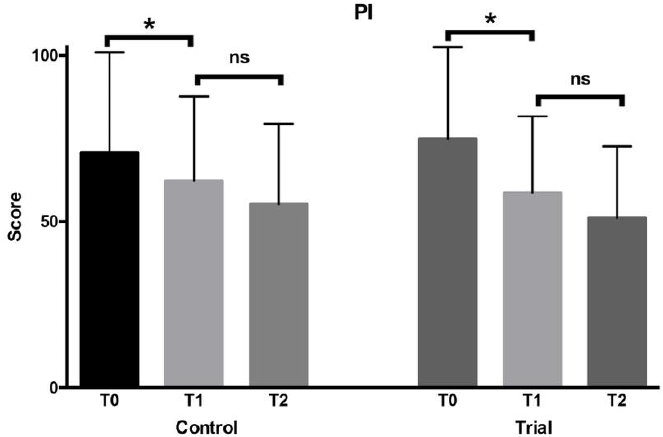
Figure 5. PI values among the time frames of the study. * = p < 0.05. ns = not significant.